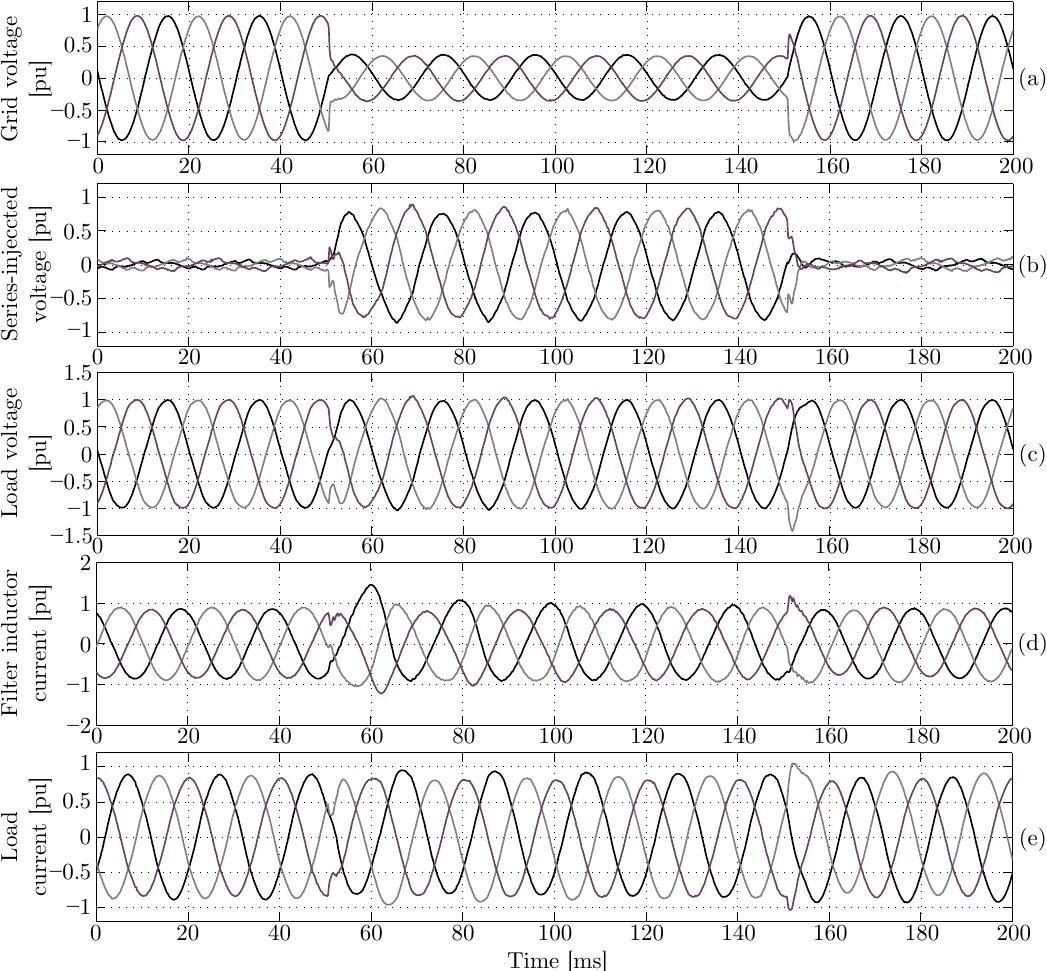
Figure 16. Experimental results. Voltage sag compensation (35% retained voltage) with the SF controller. ( a ) Grid voltage, ( b ) series-injected voltage, ( c ) load voltage, ( d ) filter inductor current, and ( e ) load